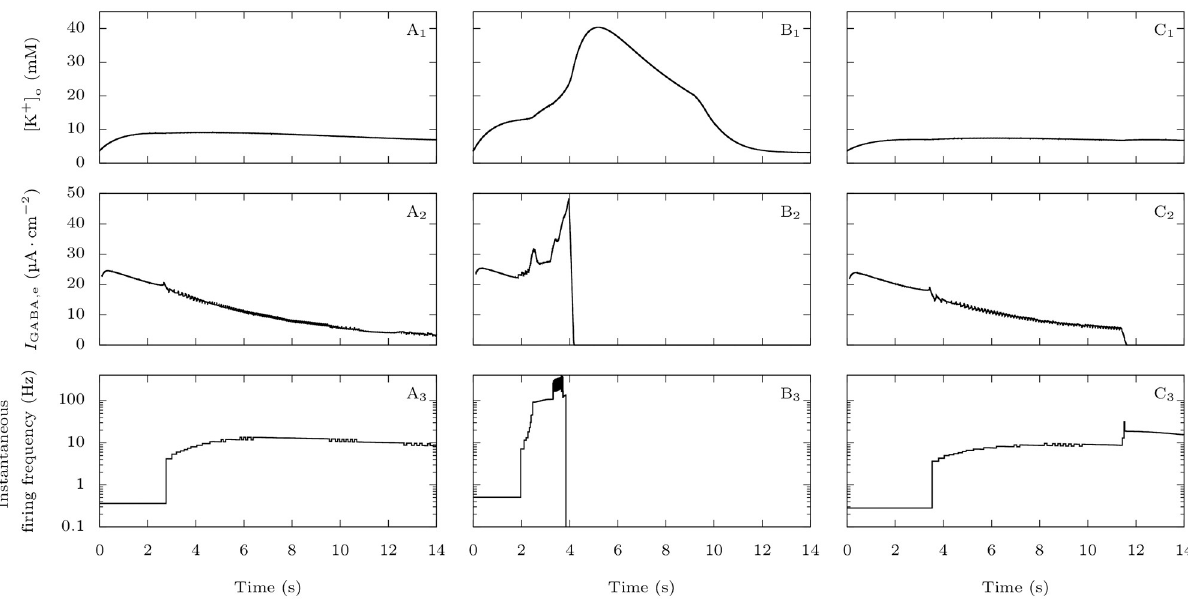
Fig 13. Comparison of migraine and epilepsy scenarios regarding extracellular potassium and GABAergic inhibition. Plots of the extracellular potassium concentration (upper row), GABAergic neuron’s inhibitory current on the pyramidal neuron (second row) and pyramidal neuron’s firing frequency (bottom row) corresponding to the simulations displayed in Figs 4 and 12. For better readability, we averaged the GABAergic currents on a running window of 200 ms. We show the pyramidal neuron’s firing frequency with a logarithmic scale. A : Control condition: default parameter values. B : Migraine condition: percentage of sodium voltage-gated conductance corresponding to persistent current p Na,P = 15%. C : Epilepsy condition: sodium fast-inactivating maximal conductance reduced to 40% of its default value.